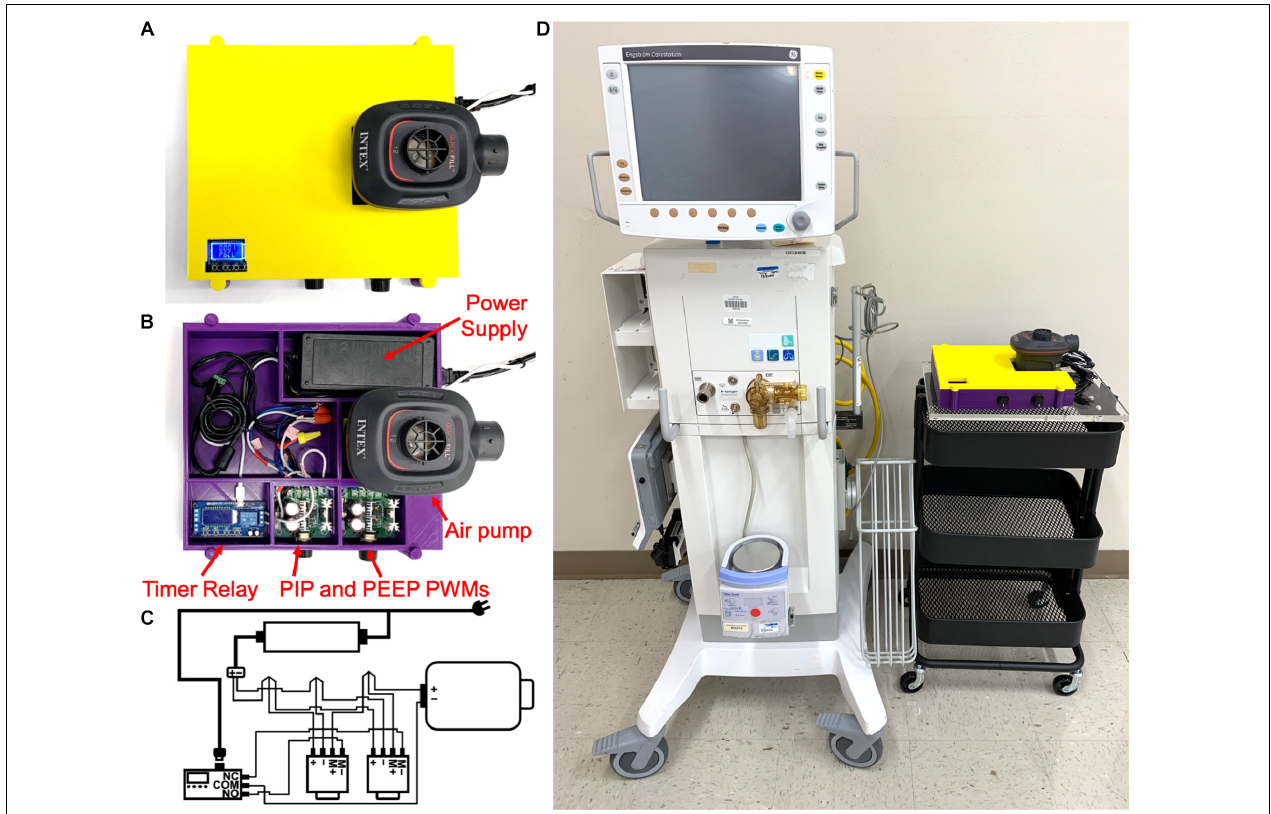
FIGURE 1 | Assembled FALCON prototype ventilator with (A) and without (B) the housing cover. (C) Wiring diagram for the FALCON prototype ventilator. Wires are connected to each other with electrical twist caps and to the 12V power supply, timer relay, and the pulse width modulators (PWMs) controlling peak inspiratory pressure (PIP PWM) and positive end expiratory pressure (PEEP PWM) with screw terminals. A 5V micro USB power adapter is used to power the timer relay ( M + = positive motor, M - = negative motor, NO = normally open, NC = normally closed, and COM = common). (D) Size comparison between the CarestationTM and FALCON prototype